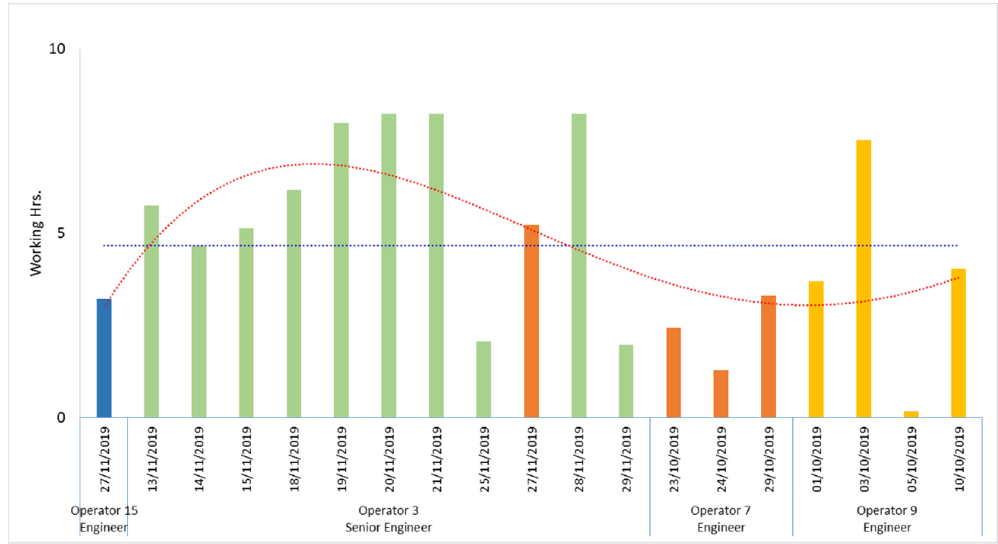
Figure 13. Customer 20, product type Analog—Q4 2019.